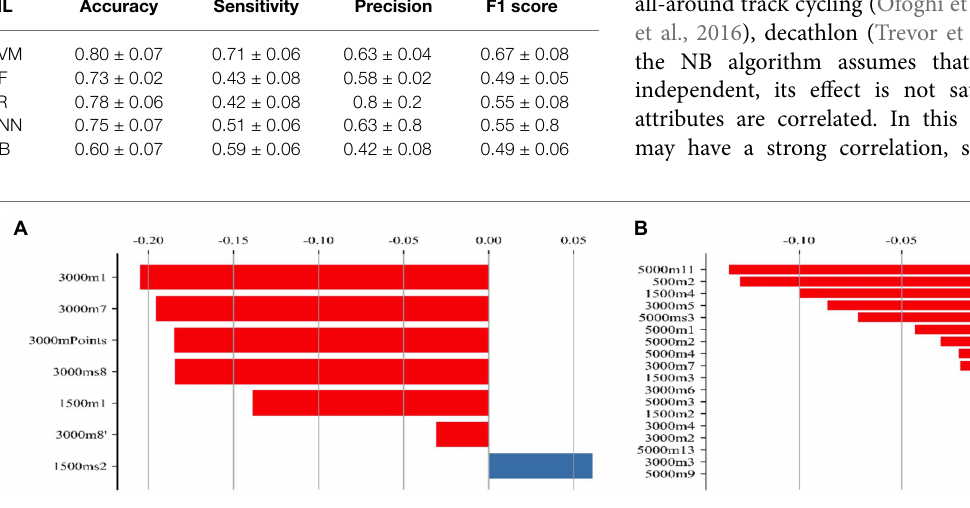
TABLE 2 | Effectiveness of the prediction models for women’s all-around speed skating medal. ML Accuracy Sensitivity Precision F1 score